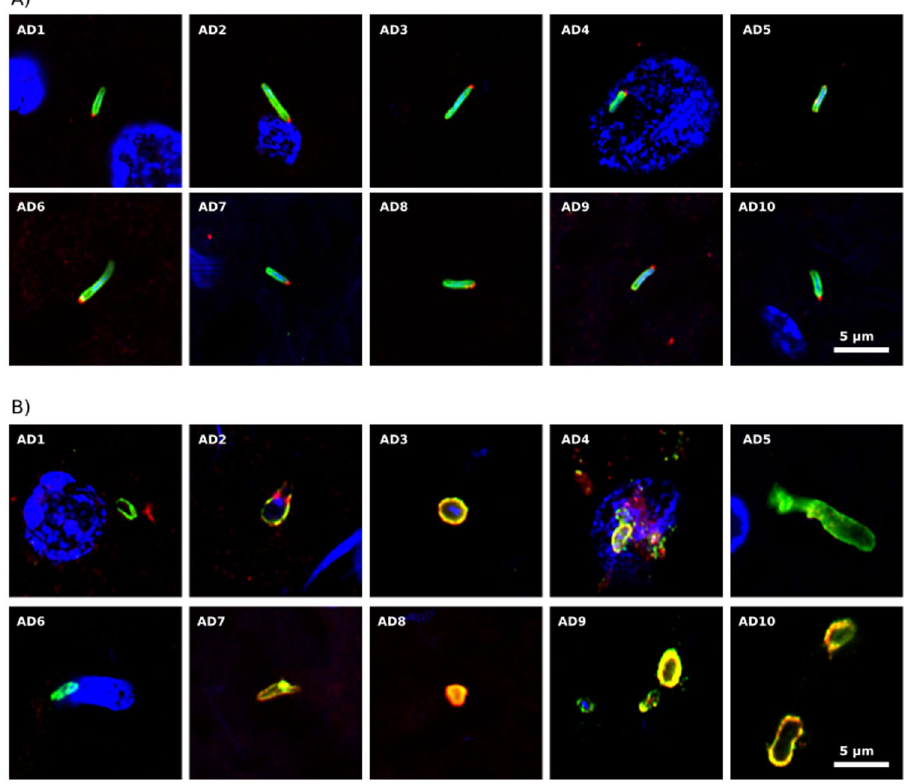
Figure 4. Immunohistochemistry of bacterial and fungal proteins in ERH sections from AD patients. Panel A: samples were immunostained with rabbit polyclonal antibody (1:20) against C. pneumoniae (green) and rat polyclonal antibody (1:20) against T. viride (red). Panel B: samples were immunostained with rabbit polyclonal antibody (1:20) against C. perfringens (green) and rat polyclonal antibody (1:20) against T. viride (red). DAPI staining of nuclei appears in blue. Scale bar as shown in the